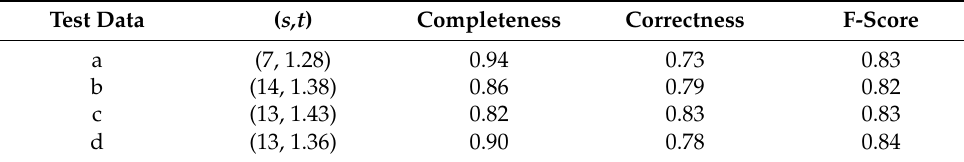
Figure 20. The surface graph of the parameter F-score with respect to parameters s and t . ( a ) The surface graph calculated from Figure 19a; ( b ) The surface graph calculated from Figure 19b; ( c ) The surface graph calculated from Figure 19c; ( d ) The surface graph calculated from Figure 19d. Table 4. The quantitative evaluation of road marking